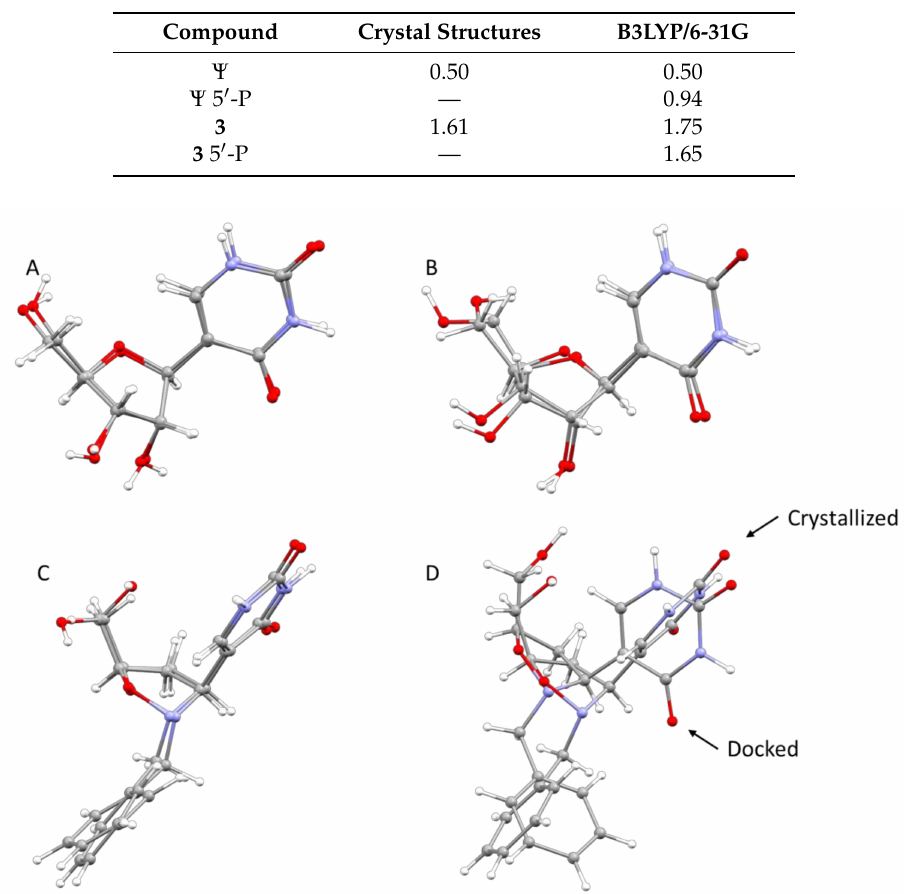
Table 7. Calculated RMSD of docked compounds from crystal structures and from minimized B3LYP/6-31G*.